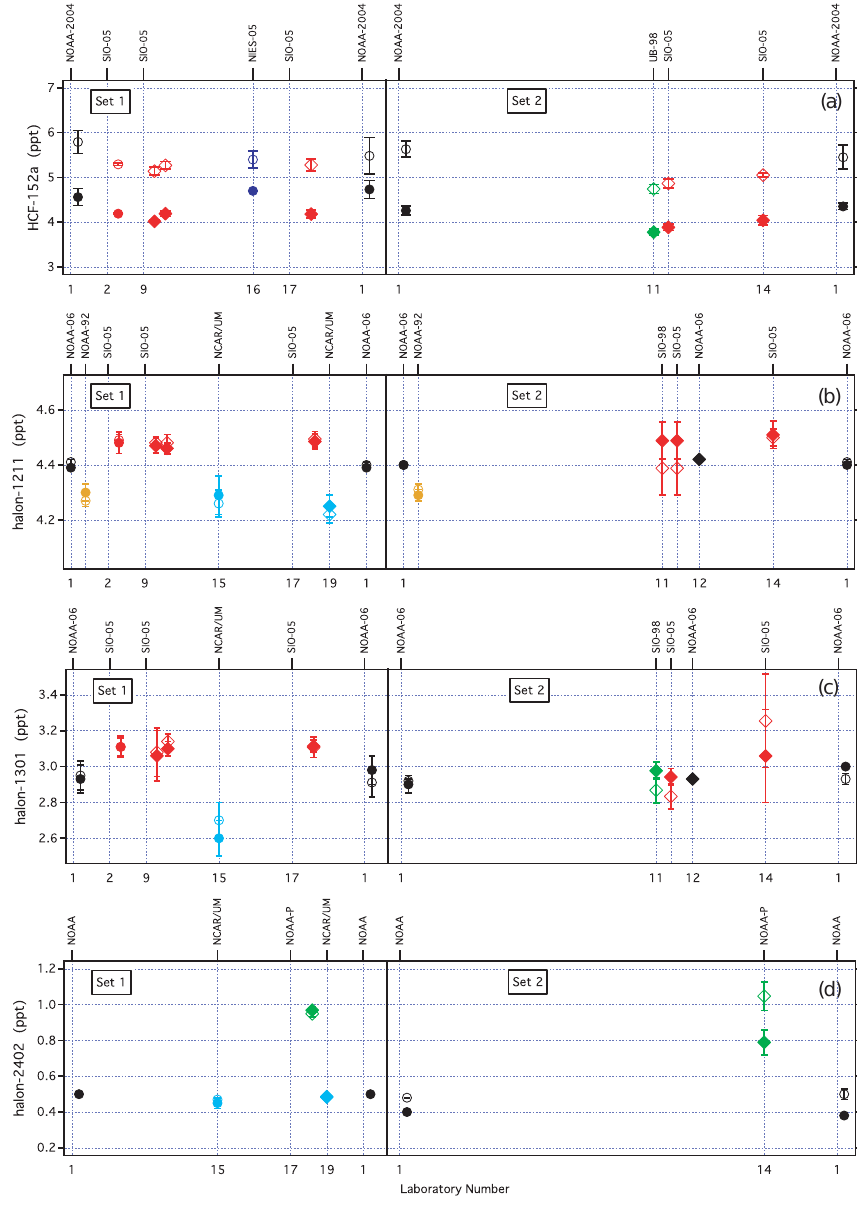
Fig. 4. Same as Fig. 1 for trace gases (a) HFC-152a, (b) halon-1211, (c) halon-1301, (d)